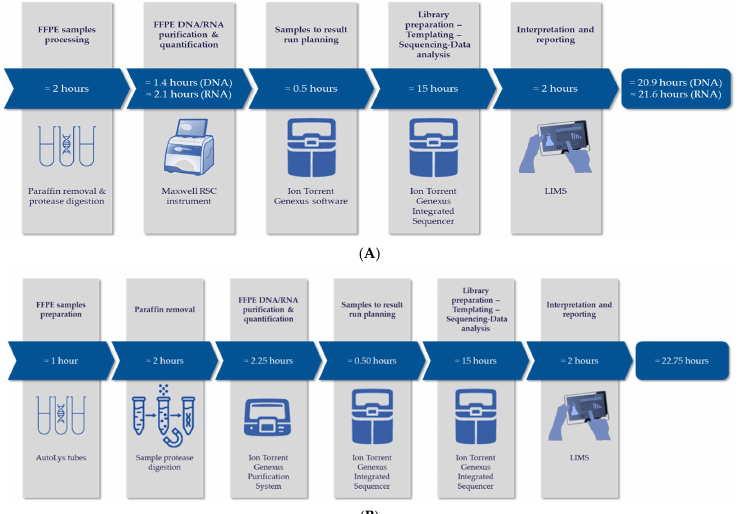
Figure 1. Genexus System workflows used in this study. ( A ) Workflow using the Maxwell automate for DNA and RNA extraction. ( B ) Workflow with AutoLys tubes and Genexus Purification System for DNA and RNA extraction.